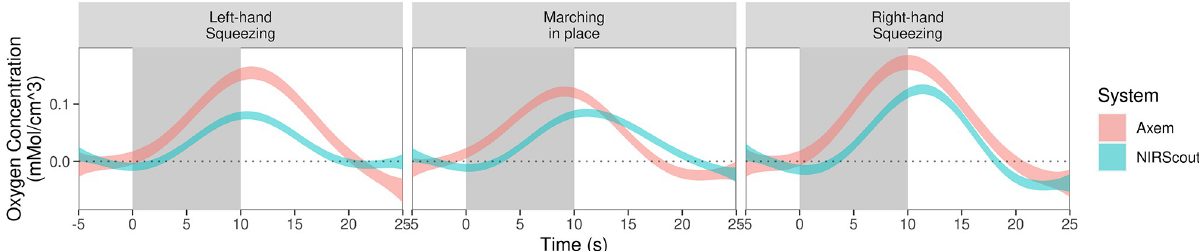
Fig 2. Δ HbO time series at most active measurement location during each motor task in each fNIRS system. For each motor task, the Δ HbO timeseries (95% confidence ribbons) from the measurement location which had the largest increase in Δ HbO for each fNIRS system are plotted; grey band mark the task period, while the dotted black line marks the mean of the 10 second period preceding the task. See S1 Fig for a plot depicting the Δ HbO timeseries data from all locations from both fNIRS systems.